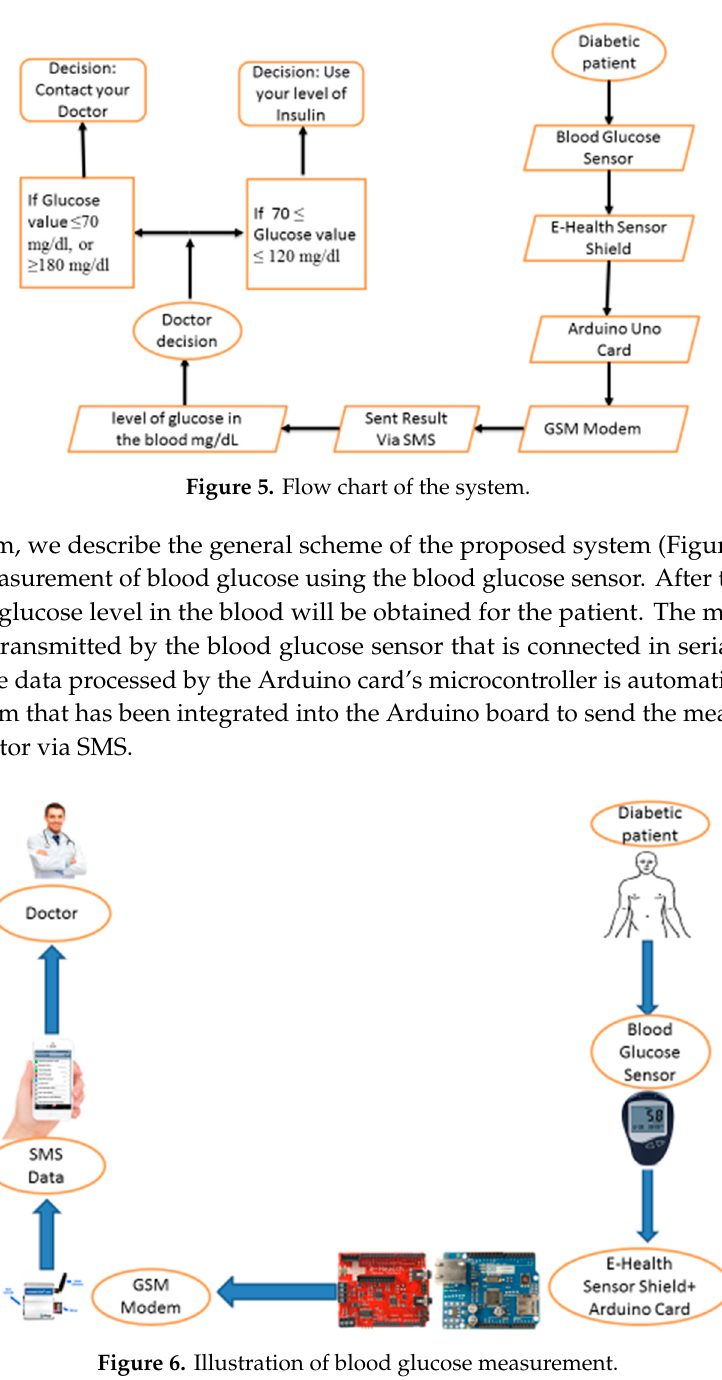
Figure 6. Illustration of blood glucose measurement.